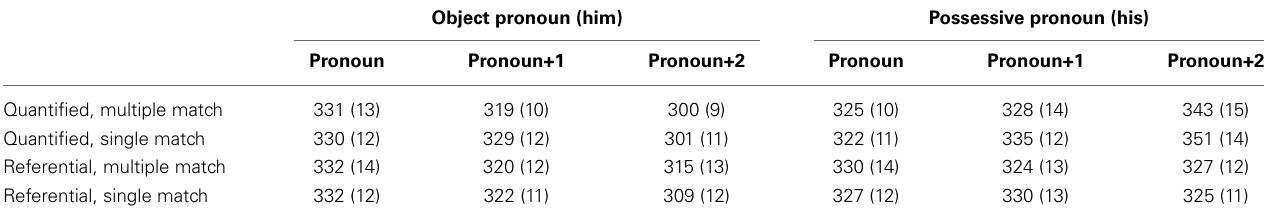
Table 5 | Grand average reading times in each ROI across all conditions in Experiment